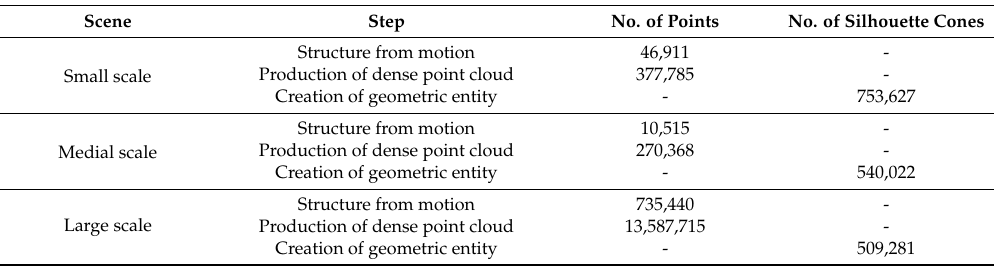
Table 6. Qualities of 3D models derived by structure from motion, production of dense point cloud, and creation of geometric